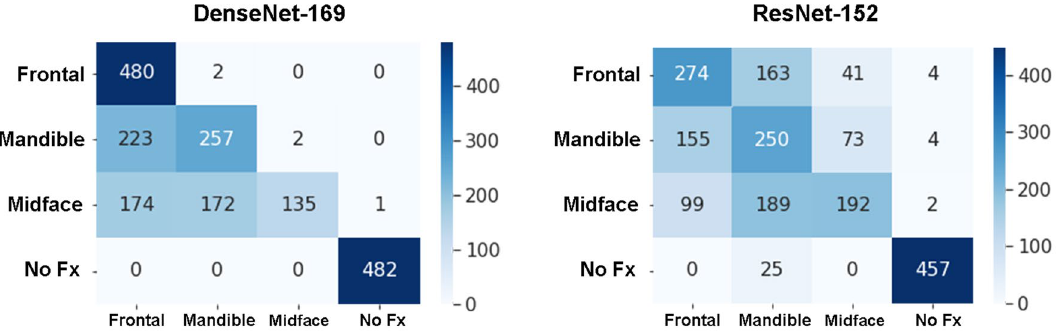
0.89, 0.86, 0.81; and 0.81, 0.77, 0.75 for frontal, midface, and mandibular fractures, respectively. AUC area under the ROC curve, Fx fracture.